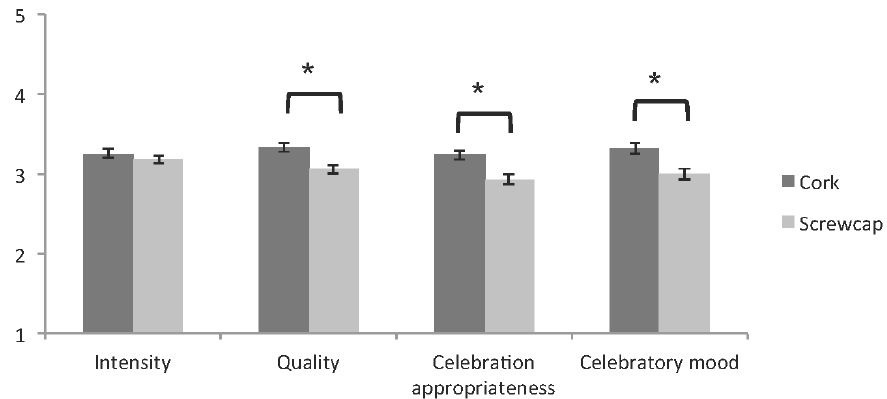
Figure 1. Mean values of wine intensity, wine quality, celebration appropriateness, and celebratory mood for wines with cork versus screw-cap enclosures. Error bars indicate standard error of means, and asterisks (*) indicate significant differences at p = 0.05. The y-axis reflects mean ratings on the 5-point scale.